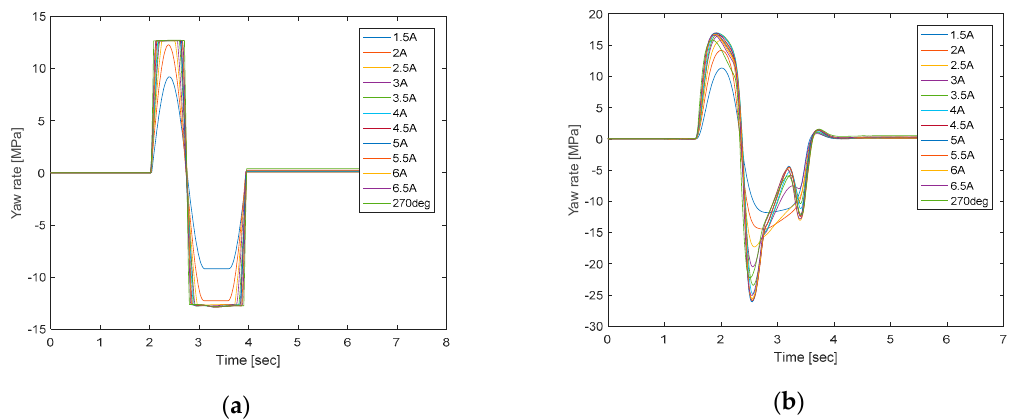
Figure 23. Based on the observation of tire force, the brake wheel cylinder pressure value under the test condition of the maximum steering angle. ( a , b ) are the brake wheel cylinder pressure values of the vehicle model using tire force observation when the maximum steering angle of the test conditions is 270 deg and the road adhesion coefficient is 0.5 and 0.8 respectively.